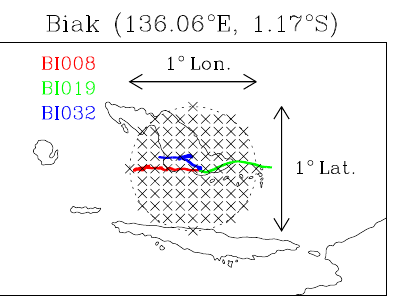
observationsaresuperposedbydots. (top) before and (bottom) after December 2006. The horizontal bars correspond to the confidence interval of